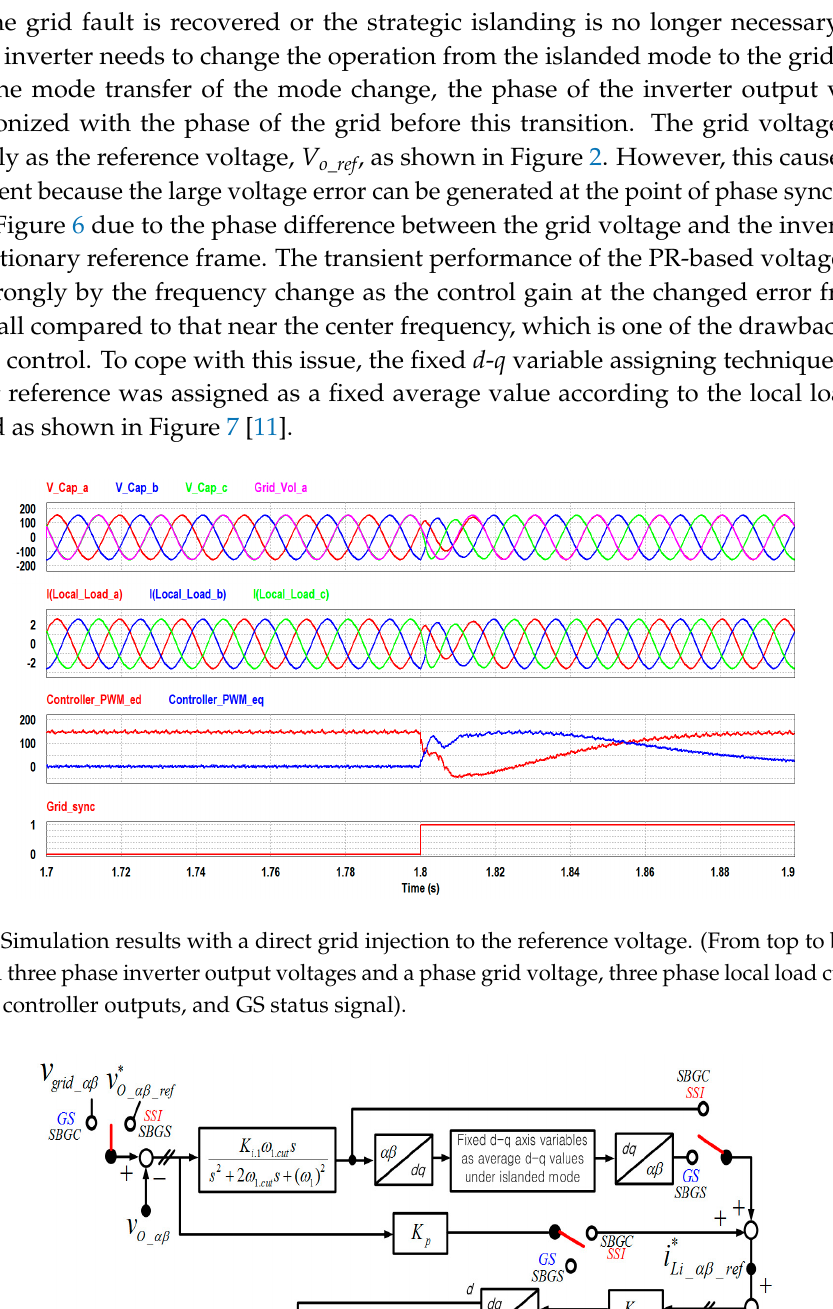
Figure 5. Bode plot of the P+MR based voltage controller with harmonics compensation: K p = 0.0577, K i. 1 ∙ω 1 .cut = 30, K i. 5,7 ∙ω 5,7 .cut = 20.